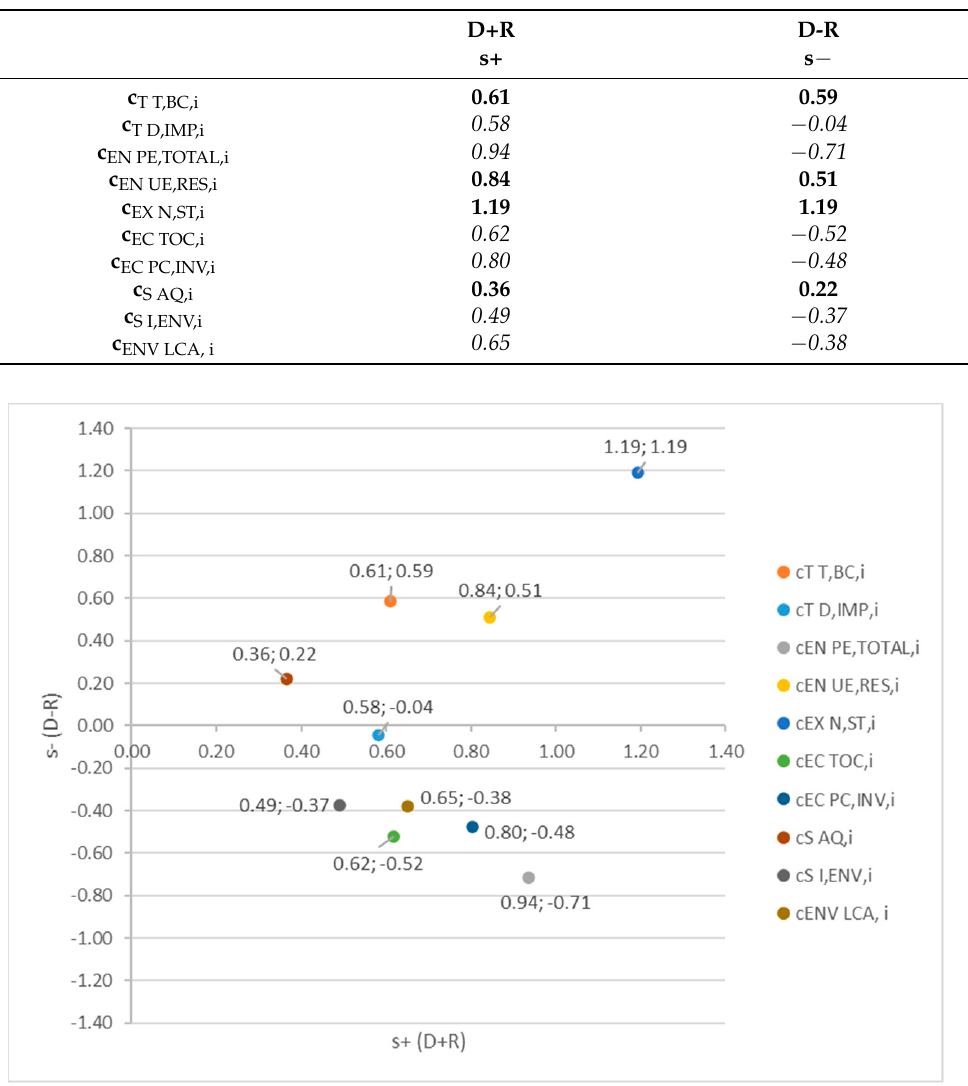
Figure 2. Classi fi cation of evaluation criteria. Figure 2. Classification of evaluation